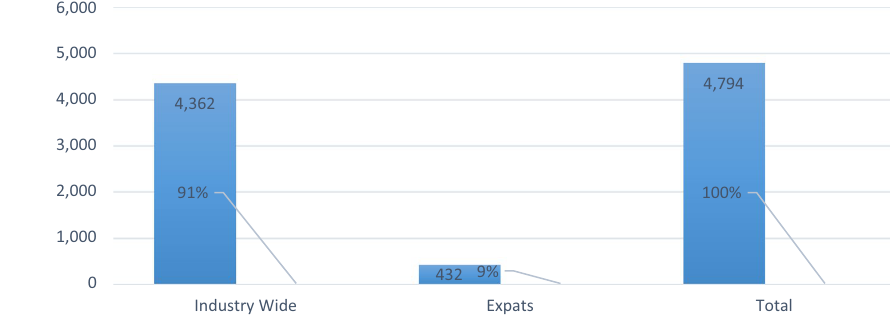
Fig. 2 Upstream localization of employment in